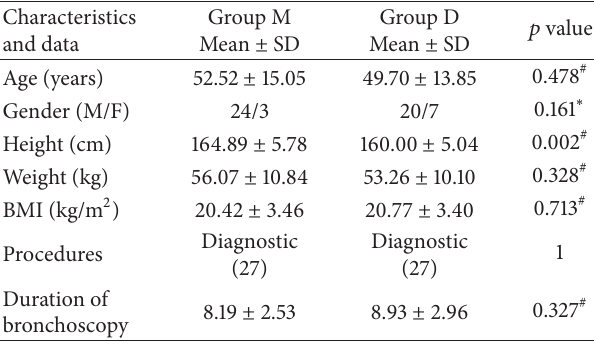
Table 2: Patients’ characteristics and bronchoscopy